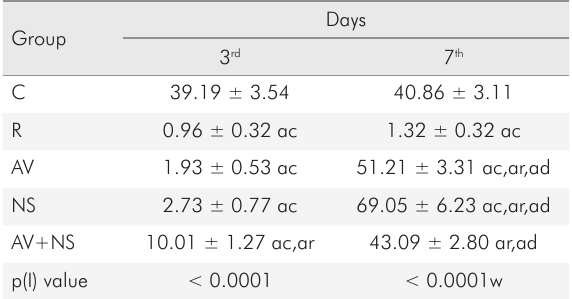
Table. Thickness of lower lip epithelium (µm, mean±SD) after oral ulcer induction throughout the experimental period and in the different groups: C, control; R, irradiated; AV, Aloe vera; NS, silver nanoparticles.